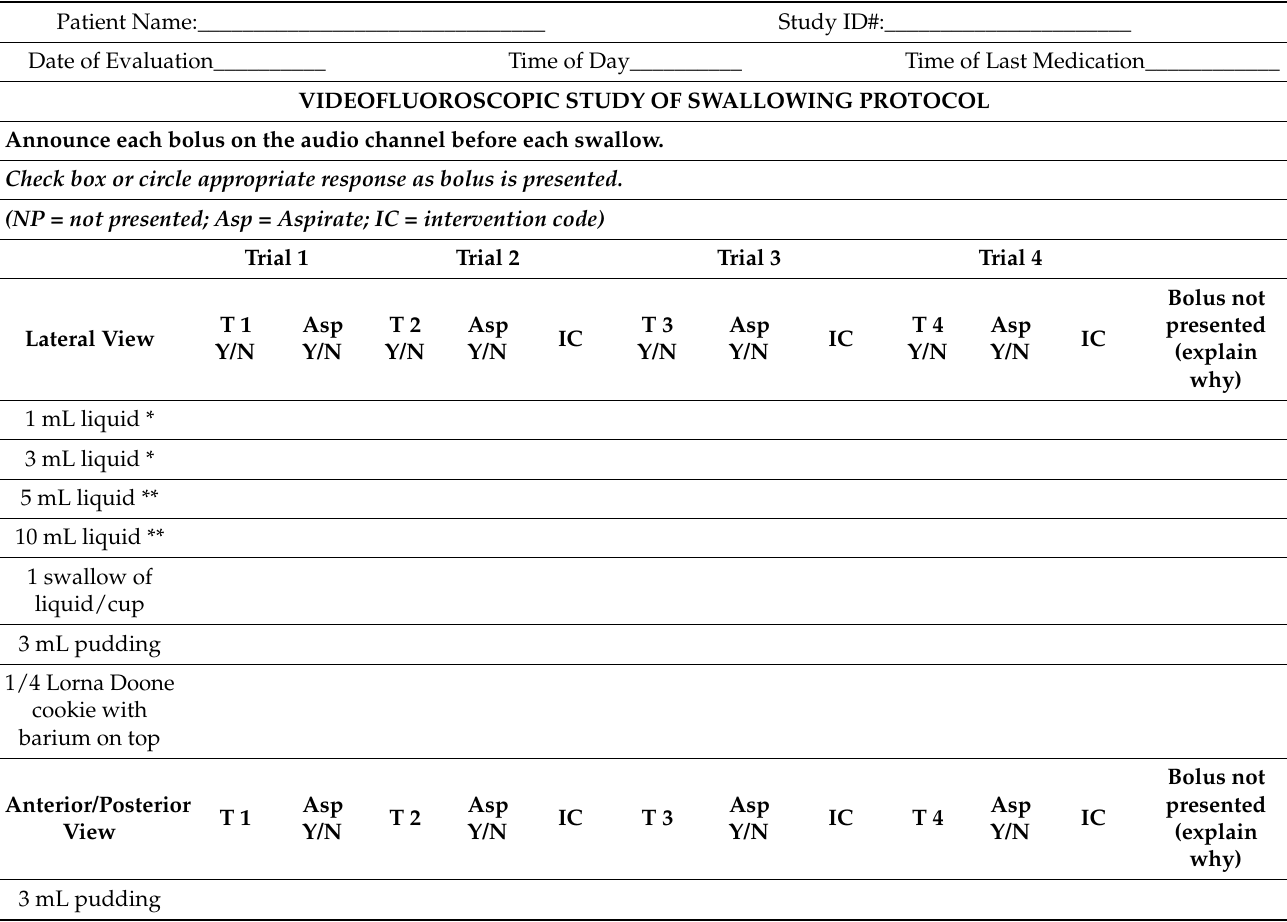
Table A6. Study: Efficacy of Speech Treatment in Parkinson’s